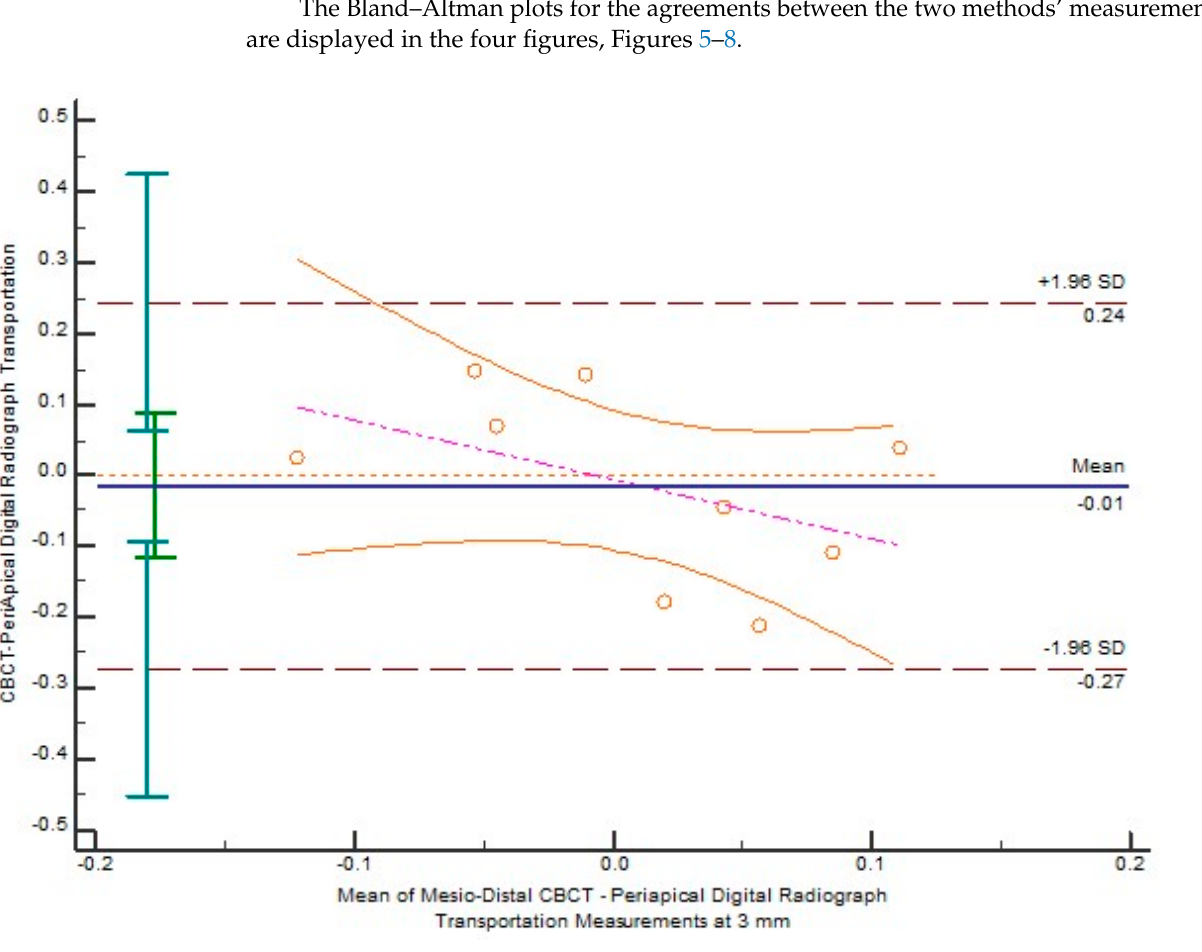
Figure 6. Bland–Altman plot for the agreement between the two methods’ measurements for the centering ratio in the bucco-lingual direction, at a level of 4 mm.